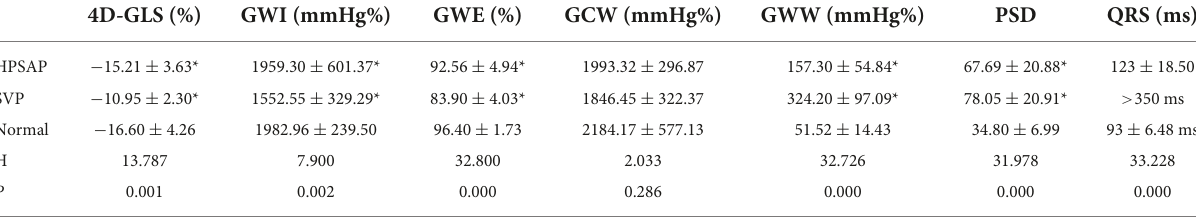
TABLE 2 Comparison of myocardial work and myocardial stratification strain among the three groups.